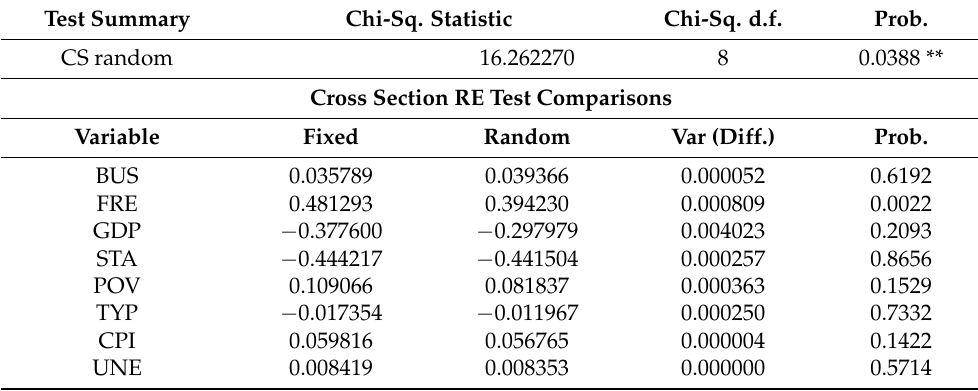
Table 5. Correlated—cross section RE Hausman